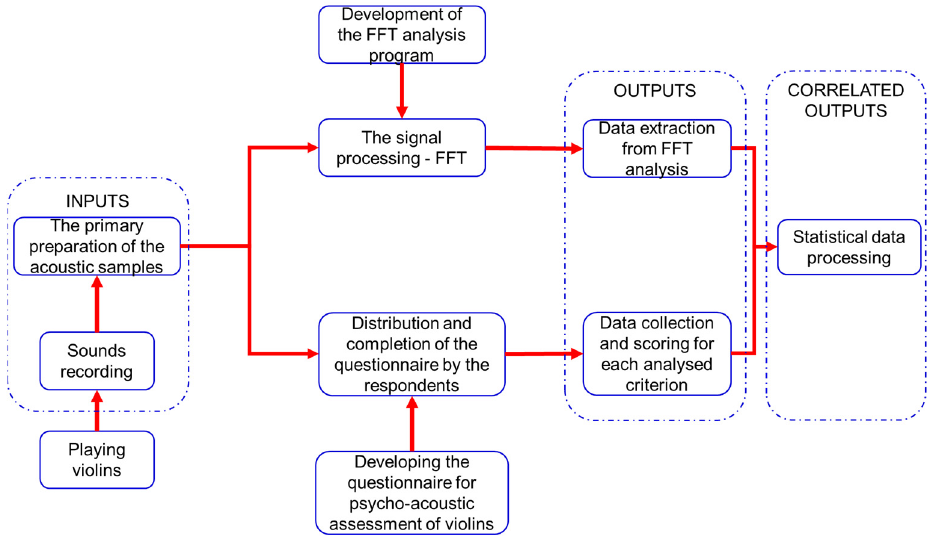
Figure 2. The block diagram of the